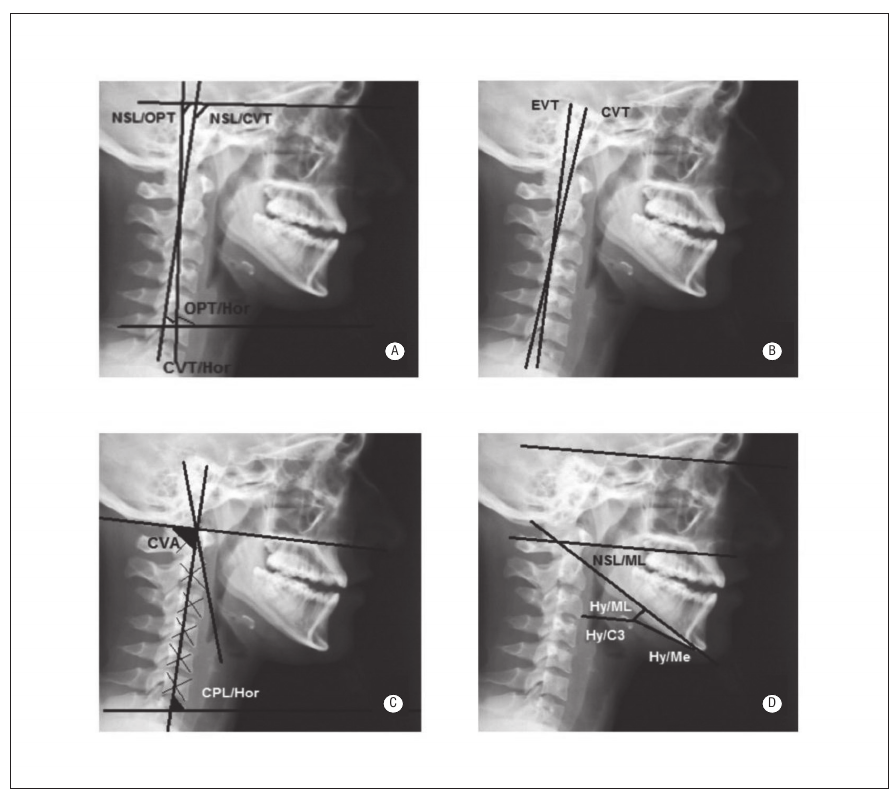
Figura 1 - Variáveis cefalométricas craniocervicais e de posição mandibular e hioidea Legenda: A) NSL/OPT = Inclinação da base do crânio em relação à cervical superior; NSL/CVT = Inclinação da base do crânio em relação à cervical (C2-C4); OPT/Hor = Inclinação da coluna cervical alta em relação à horizontal; CVT/Hor = Inclinação da coluna